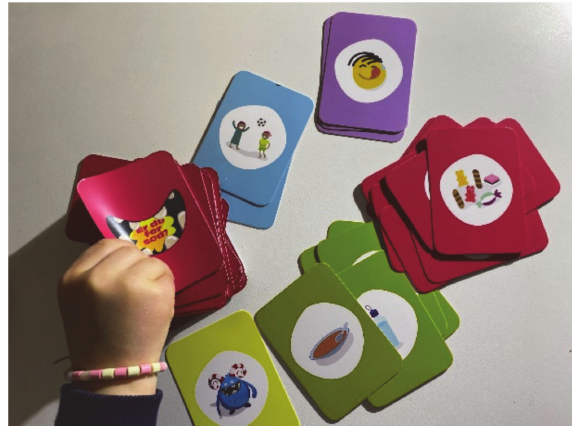
Figure 4. The card game can be played in two ways, but can also be played with as the child wishes. The cards illustrate healthy foods, discretionary foods, mood cards, situation cards and a